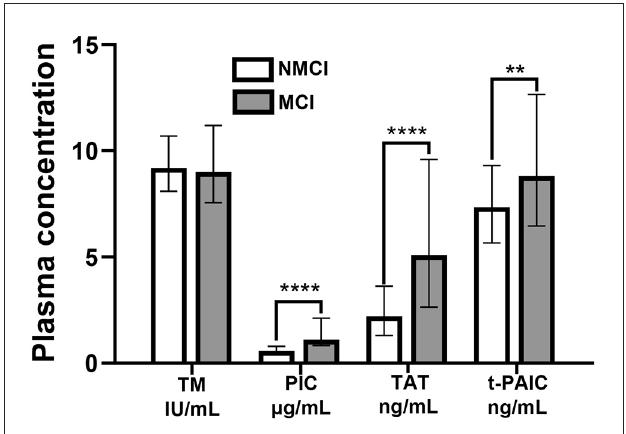
FIGURE1 Plasma concentrations of TM, PIC, TAT, and t-PAIC in the MCI group and the NMCI group. ** P < 0.01, **** P < 0.0001.